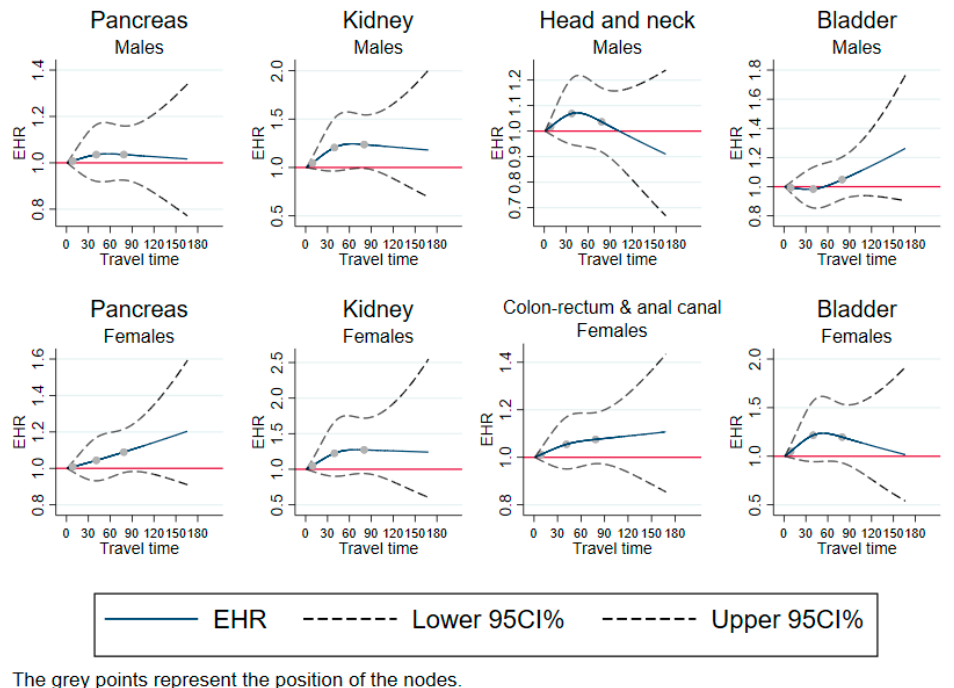
Figure 3. Excess mortality rates as a function of travel time, using restricted cubic splines—cases with no association. EHR: excess hazard ratio; CI: confidence Interval; travel time: travel time in minutes. Adjusted for year of diagnosis, age, and European Deprivation Index.